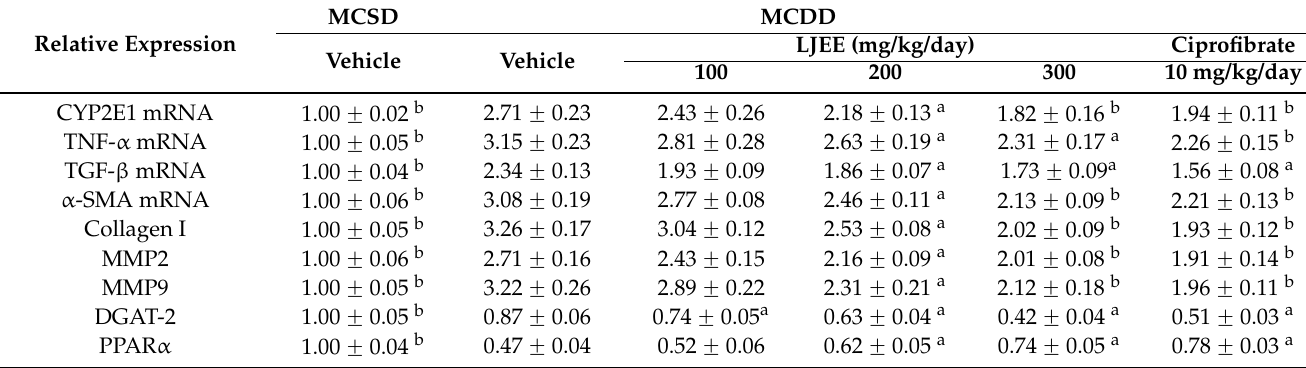
Table 3. Effects on hepatic mRNA expression of NASH-related specific genes in MCSD- or MCDD-fed mice receiving four weeks of